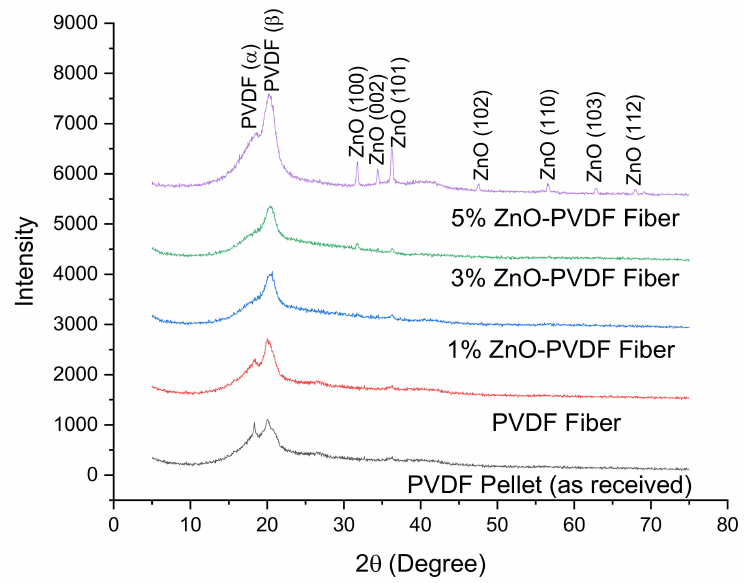
Figure 5. X-ray di ff raction (XRD) pattern of PVDF and ZnO-PVDF fibers.